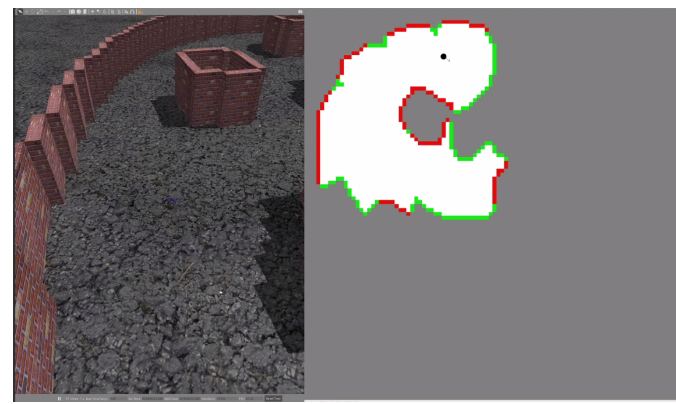
Figure 9. Policy Test Environment.